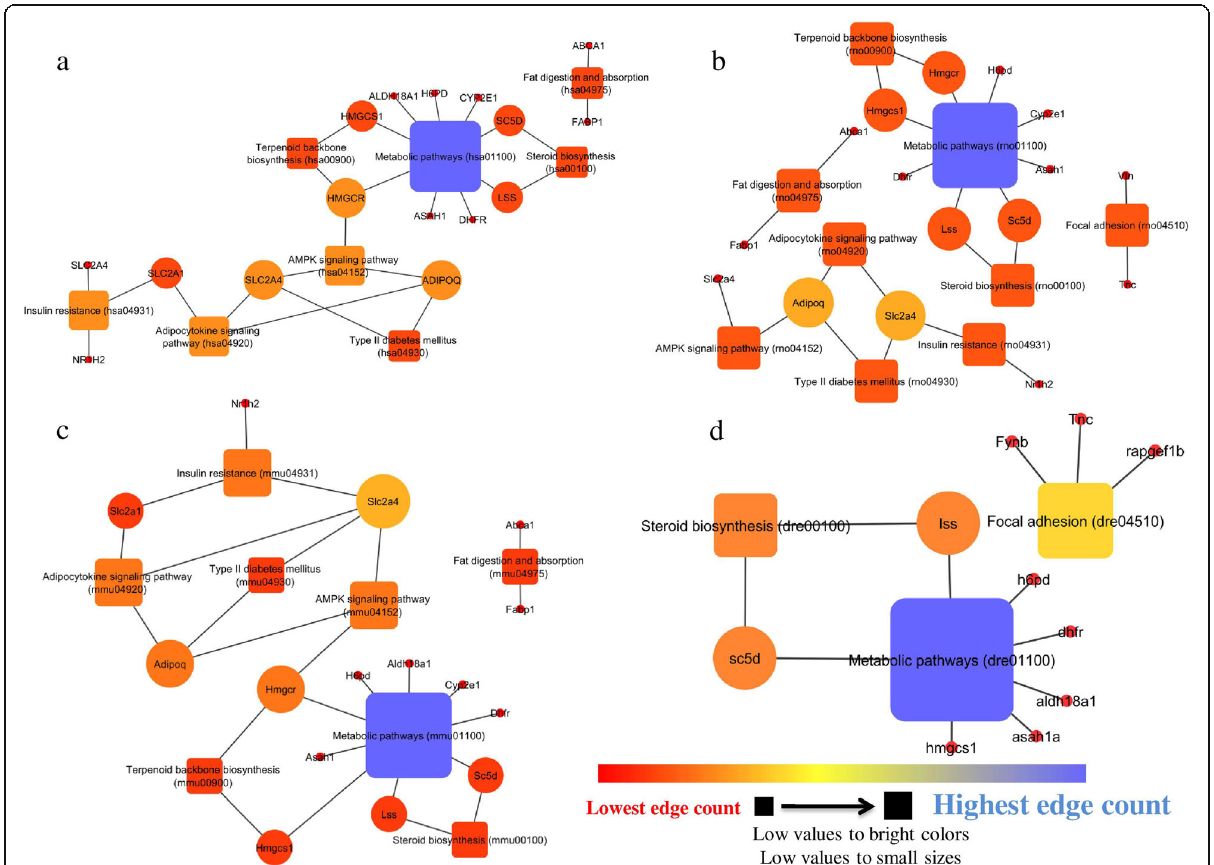
Fig. 1 Olanzapine-induced gene-pathway interaction a Homo sapiens , b Rattus norvegicus , c Mus musculus , and d Danio